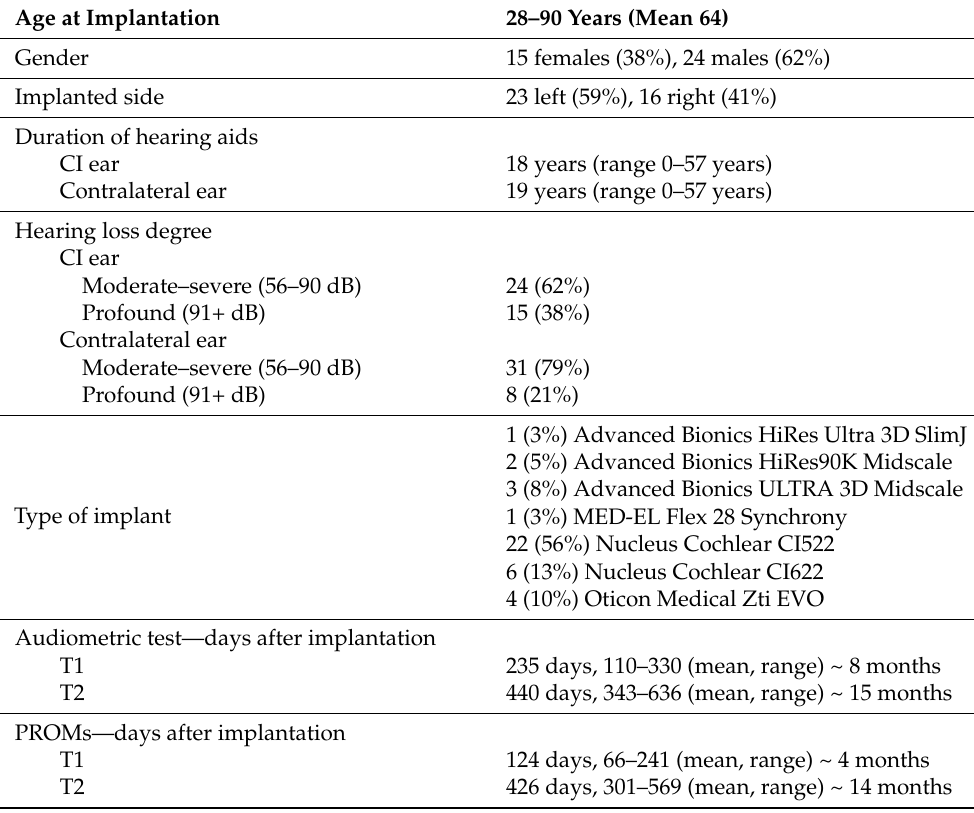
Table 1. Demographic characteristics of the 39 study